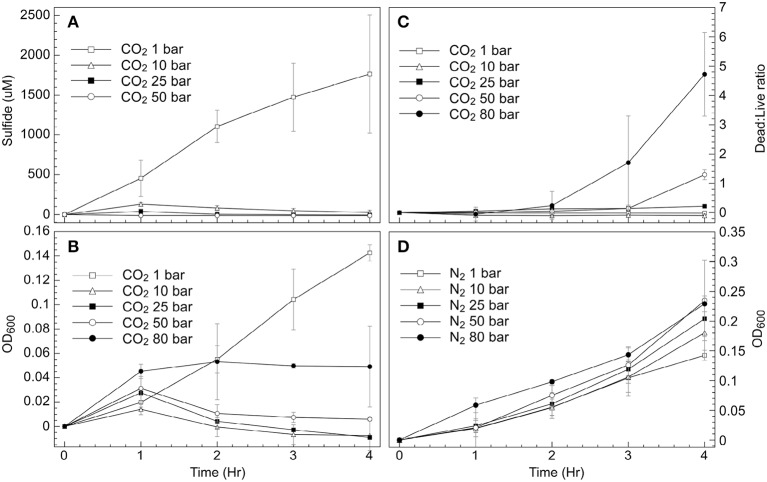
Exposure of D. vulgaris biomass to CO2 or N2 at a series of pressures. Values show changes from measurements made at T = 0 (A) Sulfide concentrations under CO2; (B) Optical density (OD600) under CO2 headspace; (C) Live:Dead cell ratios under CO2; (D) Optical density (OD600) under N2 headspace.